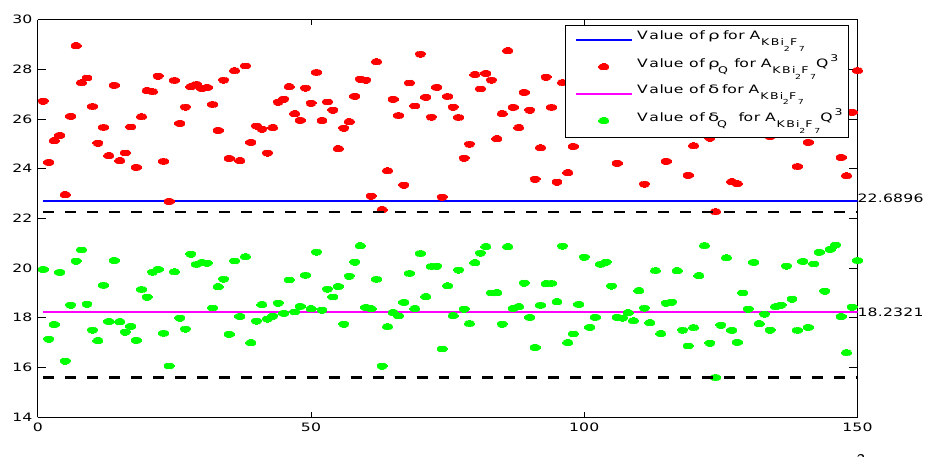
Q 3 . and A KBi 2 F 7 2 F 7